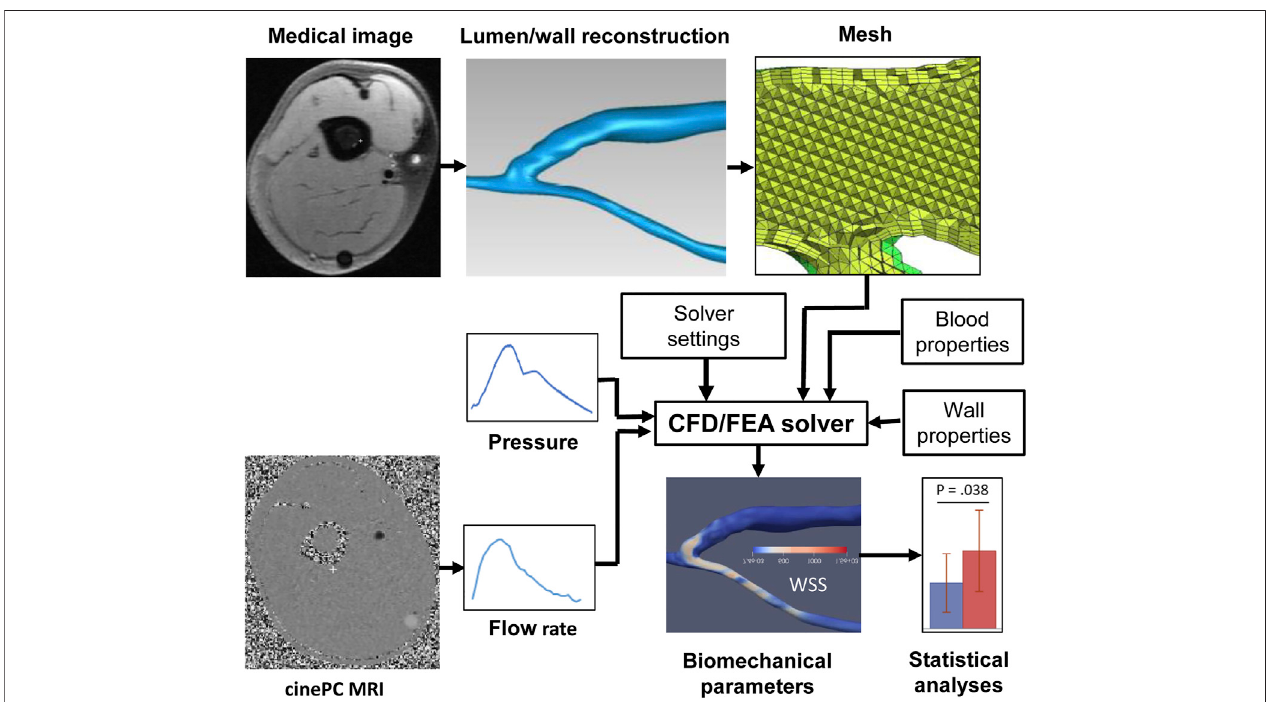
FIGURE 1 | Pipeline of a typical image-based vascular CFD/FEA simulation. CFD, computational fl uid dynamics, FEA, fi nite element analysis, PC MRI, phase- contrast magnetic resonance imaging, WSS, wall shear stress.